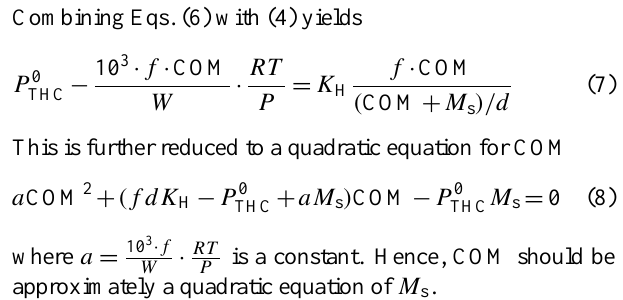
Figure 2. The condensed organic mass ( COM ) on neutral sulfate seed particles. It is approximately a linear function of the available sulfate particle mass regardless of particle sizes.